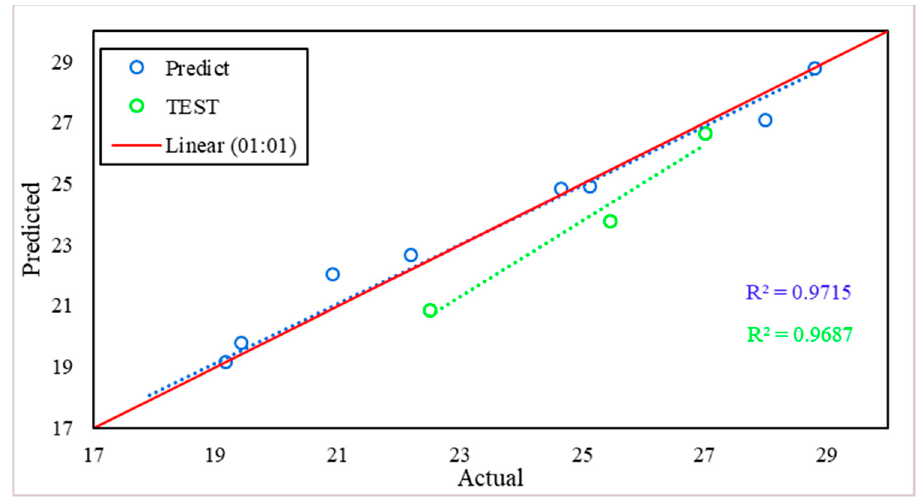
Figure 24. Compressive strength scatter plot between actual and predicted values.